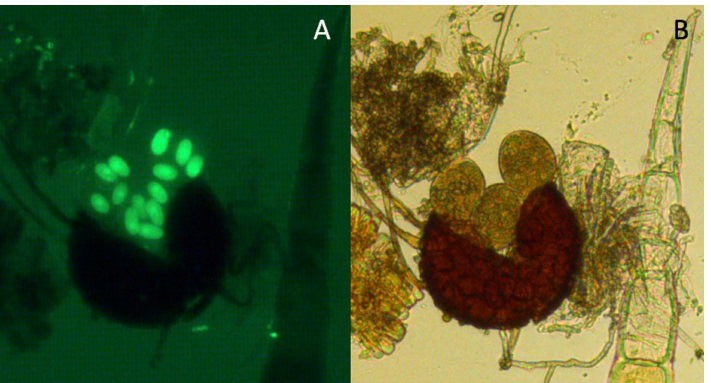
Figure 3. Open chasmothecia showing asci with ascospores. Both images show the result of the same preparation stained with fluorescein diacetate under ( A ) fluorescence and ( B ) brightfield microscopy (40 ×